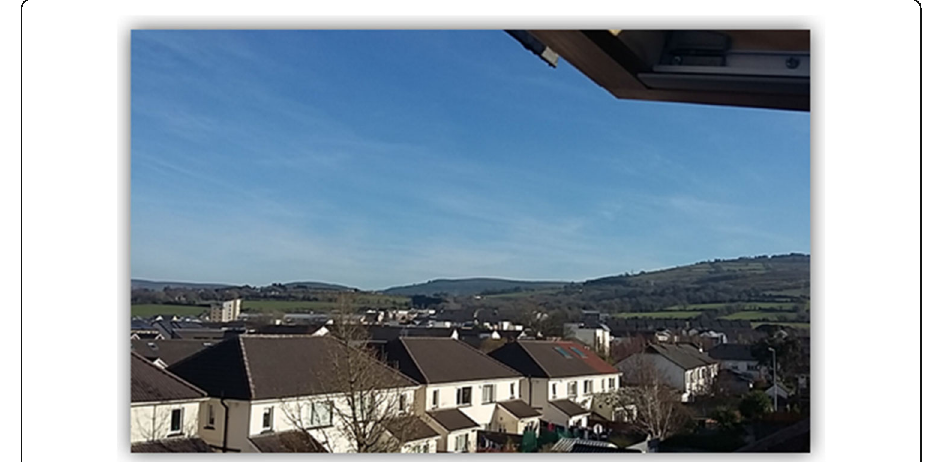
Fig. 6 The view from my attic office. (P18, eportfolio entry